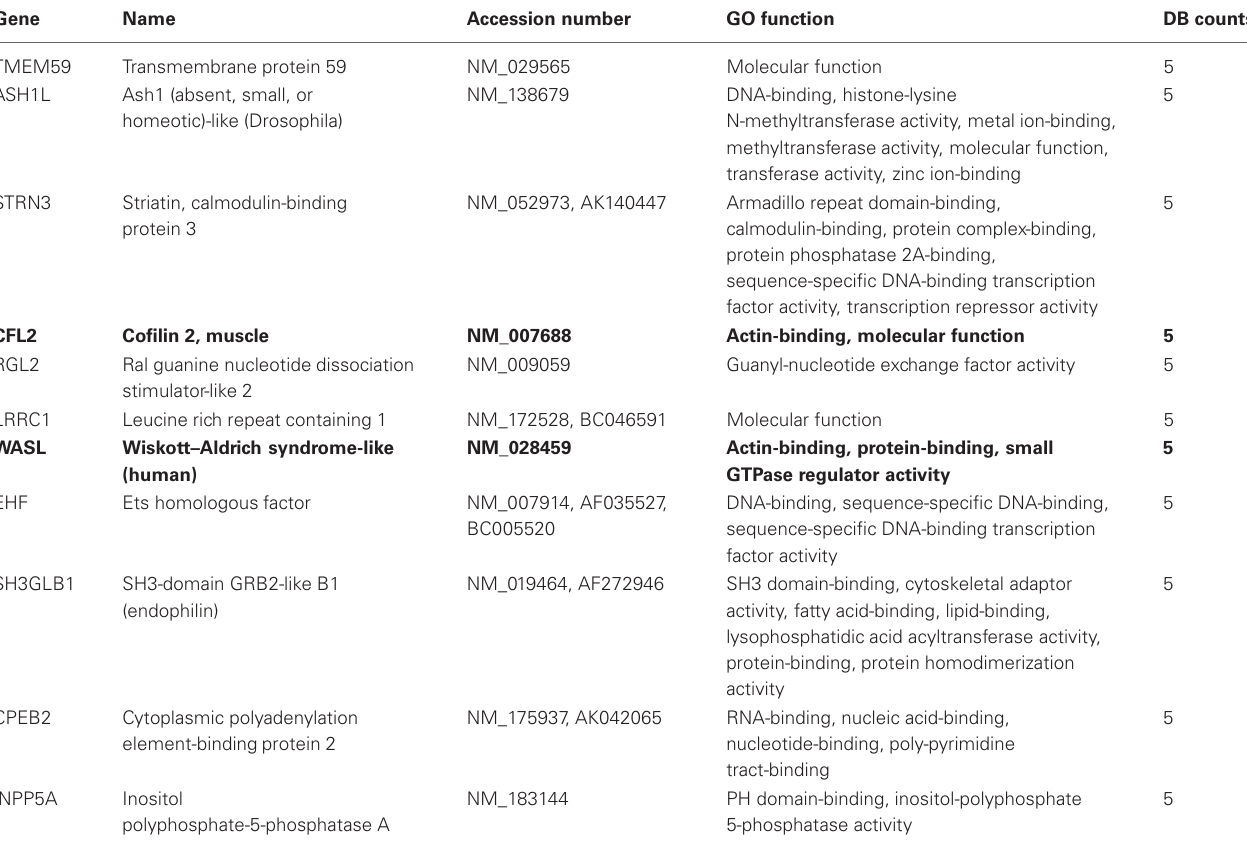
Table 2 | The detailed listing of the 11 genes that appear in the 5 databases.